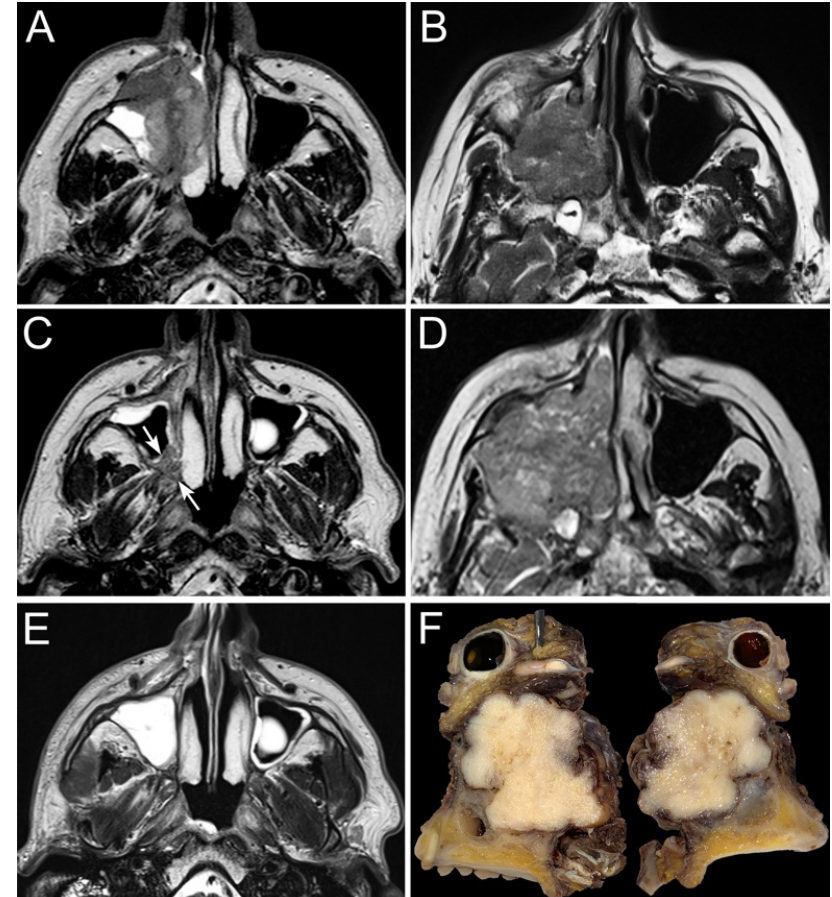
Figure 3. The panel shows two examples of locally advanced poorly differentiated squamous cell carcinoma of the right maxillary sinus ( A , B ). Both patients underwent neoadjuvant chemotherapy (3 cycles) with taxane, cisplatin, and 5-fluorouracile, which resulted in a heterogenous response: the first tumor ( C ) showed a partial response (arrows), whereas the second one ( D ) progressed throughout chemotherapy. Based on the response to chemotherapy, the first patient was treated through intensity-modulated proton therapy combined with concomitant platinum-based chemotherapy, which led to a complete response with no relevant toxicity ( E ). The second patient was instead operated on through a total maxillectomy extended to the infratemporal fossa and upper parapharyngeal space, orbital exenteration ( F ), anterior and middle craniectomy with dural resection, skull base multilayer graft-based reconstruction, and anterolateral thigh free